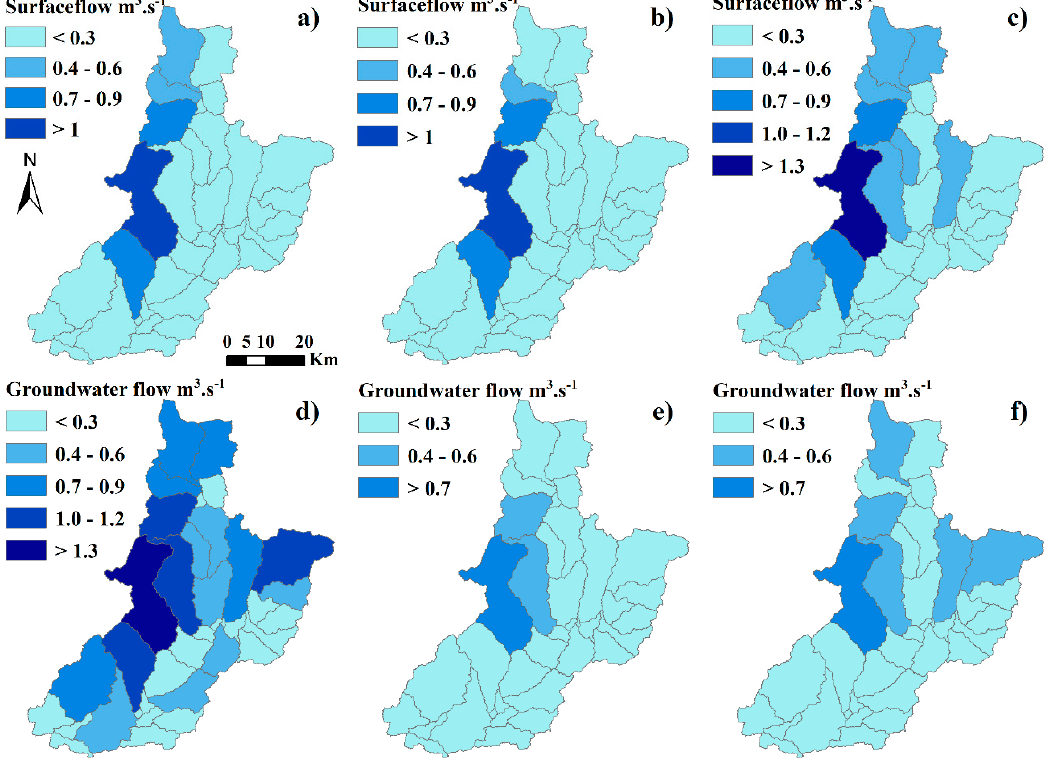
Figure 11. SWAT output maps of ( a – c ) the surface flow and ( d – f ) the groundwater flow. The surface flow matches ( a – c ) the reference model, the afforestation scenario, and the wildfires scenario, respectively. The groundwater flow matches ( d – f ) the reference model, the afforestation scenario, and the wildfires scenario, respectively.